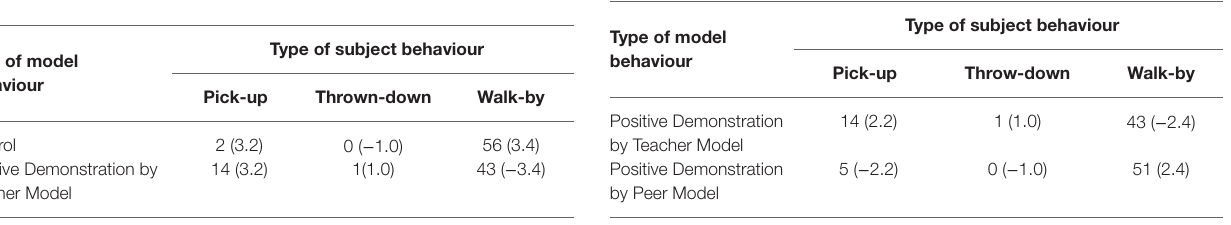
TABLE 3 | Crosstabulation of model behaviour type and subject behaviour